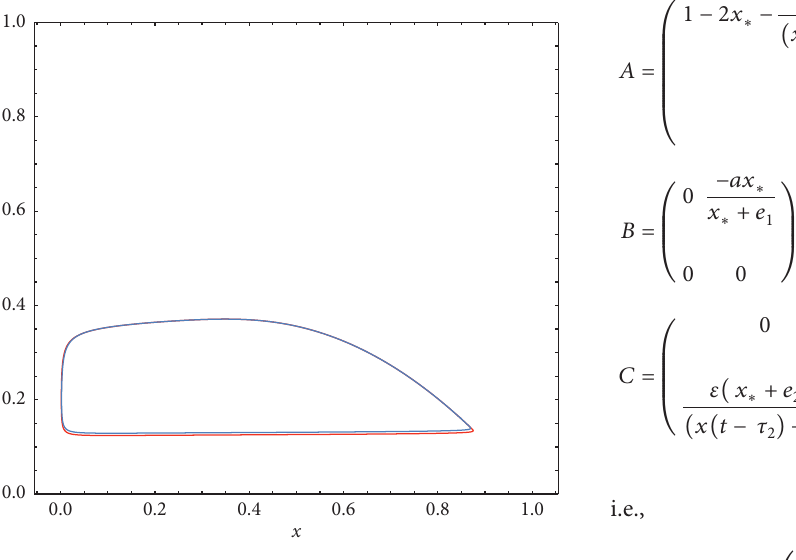
Figure 4: Phase space: the dashed blue curve shows the orbit of system (9) and the red full curve shows the orbit of system